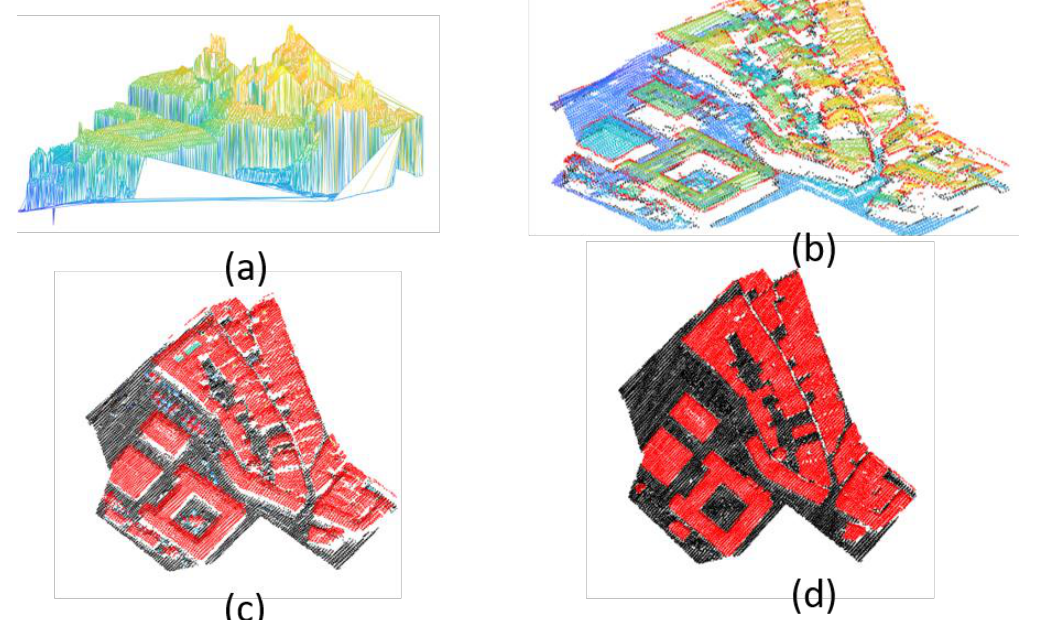
Figure 3. Point cloud classification. ( a ) Delaunay Triangulation of the point cloud, T P ns . ( b ) The geometric features of the triangulation are employed to find the connections between roofs (red points) and ground (black points), which can be used to perform the segmentation using a region growing algorithm. ( c ) Result of the region growing algorithm. It can be seen that some points are still not classified or misclassified, being a refinement needed at this point. ( d ) Results after the labelling refinement.